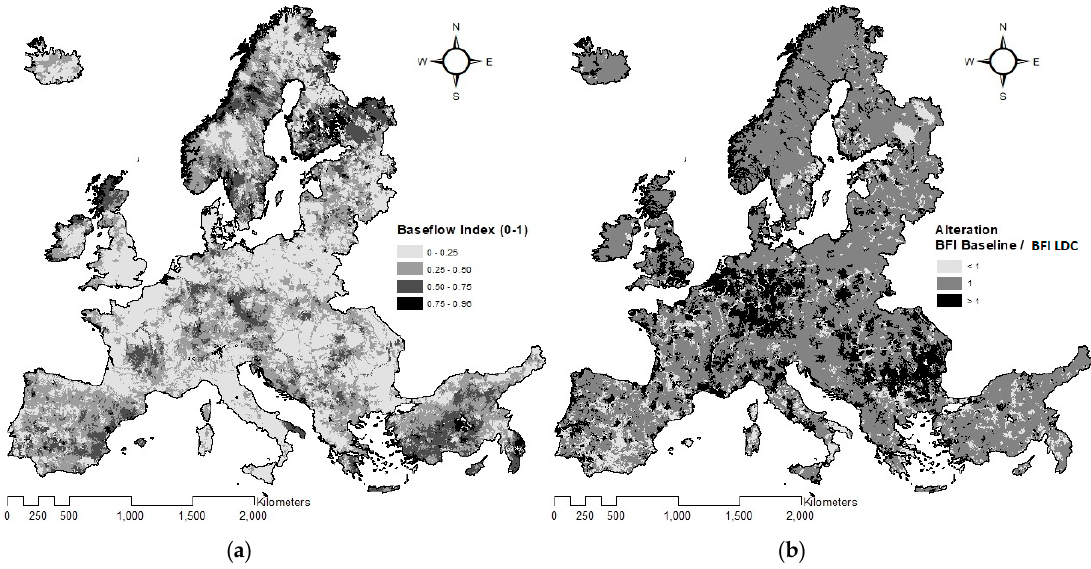
Figure 4. ( a ) Baseflow index (BFI) of the 10-y period under the least disturbed conditions (LDC) scenario, i.e., the scenario of the historic climate 2001–2010 with the LDC. BFI is defined as the 7 day minimum flow/mean annual flow of the year. ( b ) Alteration of the BFI from the least disturbed conditions, expressed as BFI (baseline)/BFI (LDC). Ratios below unity indicate decrease in BFI due to abstractions, values equal to unity show no alteration and values above unity show increase from the least disturbed conditions. Reduction is depicted on the right map with lighter colors and is observed mostly in parts of the Mediterranean countries. Increase in BFI (ratio > 1) is found in Central and Eastern Europe. Very large parts all across the continent and especially in the North remain unaltered with respect to BFI (ratio = 1).